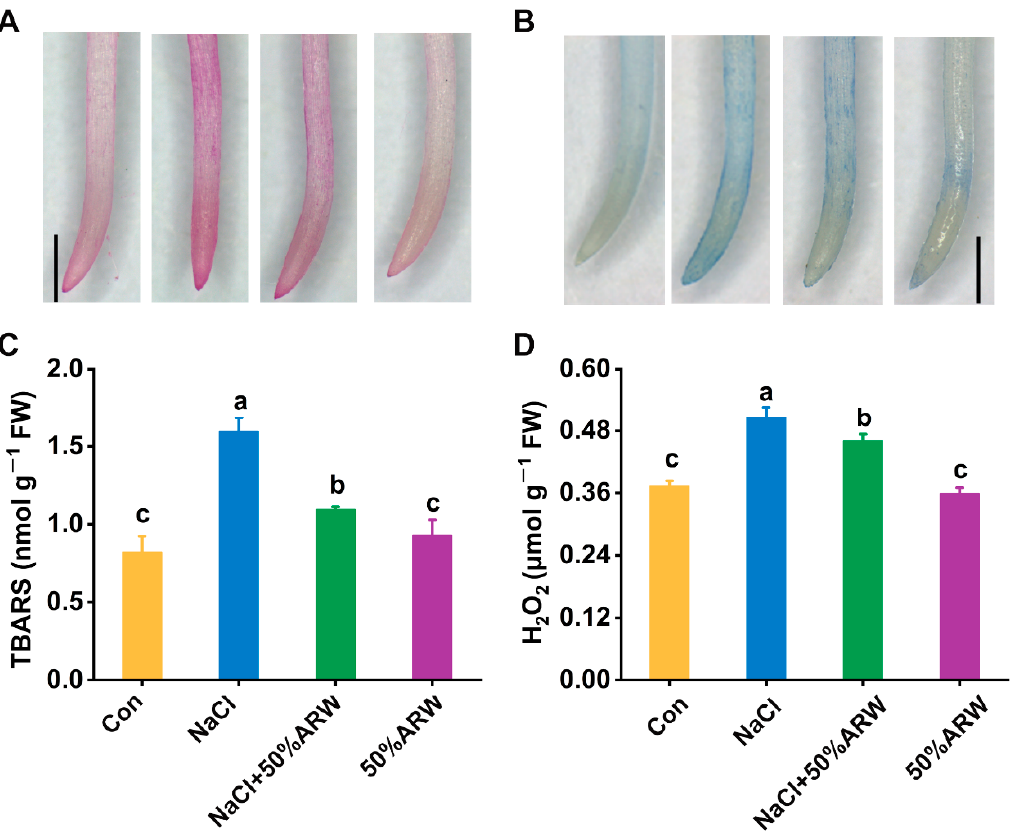
Figure 8. Argon alleviates NaCl-induced oxidative damage. After 21 days of pot treatment, the roots were stained with Schiff’s reagent ( A ) and Evans blue ( B ) to determine lipid peroxidation and plasma membrane integrity, respectively. Bars = 1 mm. The contents of TBARS( C ) and H 2 O 2 ( D ) in root tissues were analyzed. The error bars represent the SD. Bars with different letters were significantly different at p < 0.05 according to Duncan’s multiple range test.